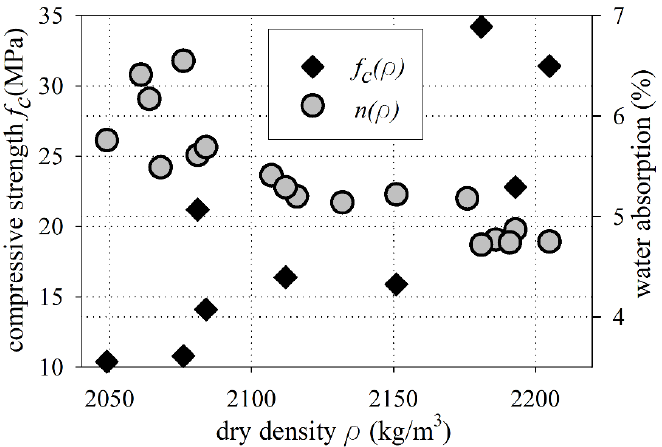
Figure 5. Compressive strength and water absorption vs. dry density.